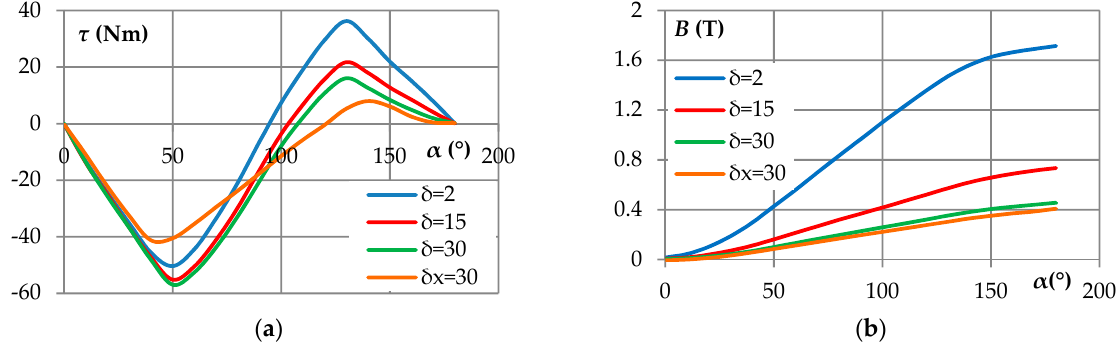
Figure 6. Dependence of reluctance torque τ ( a ) and flux density B on angular position of movable element α for working gap δ = 2, 15, 30 mm (for exciter shown in Figure 4) and ( b ) δ x = 30 mm (for exciter shown in Figure 5) .